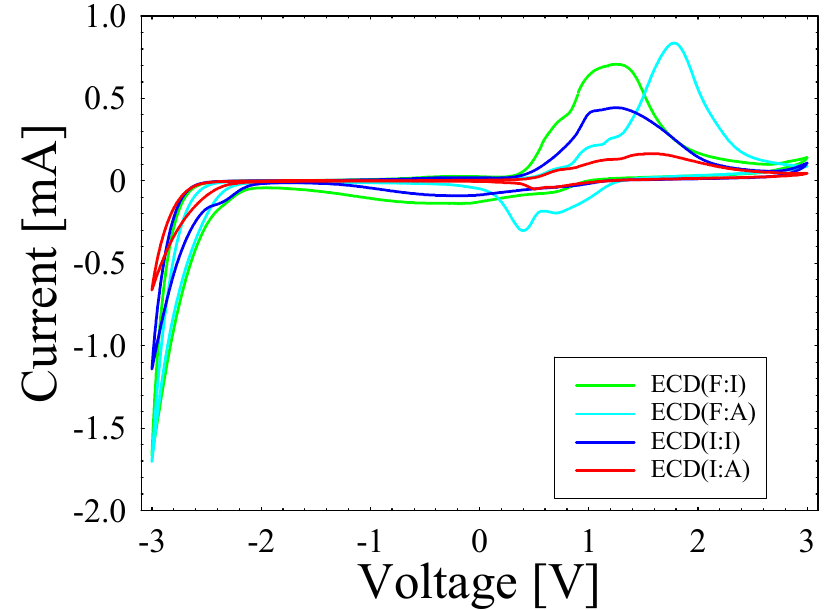
Figure 2. CV curves of ECDs with various combinations of transparent electrodes.